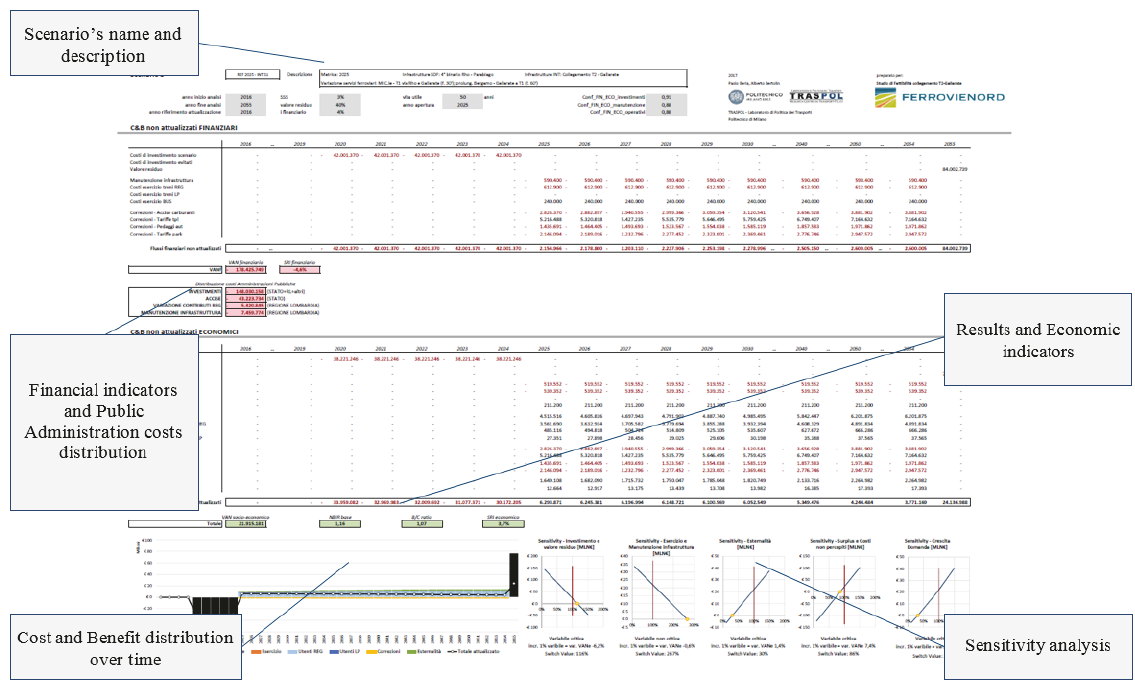
Figure 7: An example of Appraisal Summary Table organisation.